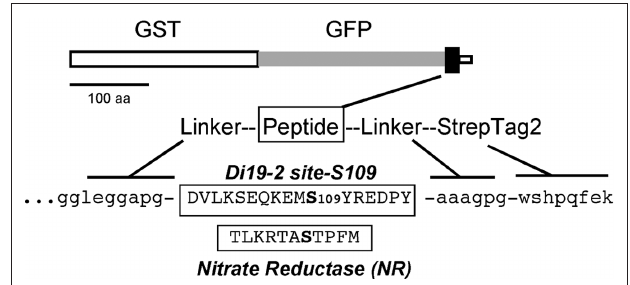
Figure 2 | Diagram of the fusion protein system used for analysis of CPK phosphorylation sites from Di19-2 ( G-S 109 -ST , ps1160) and nitrate reductase (ps699). In some experiments, a similar fusion system was used in which the GFP was replaced by an RFP ( G-RFP-NR-ST